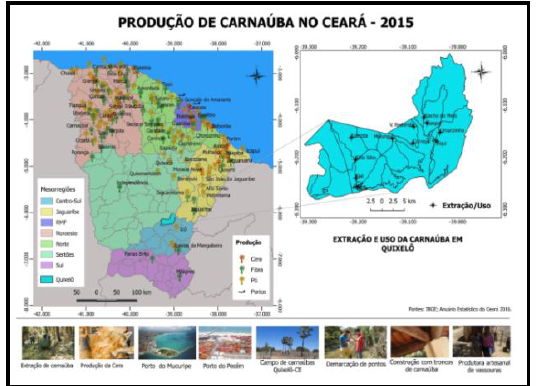
Figure 1. The Carnaúba Palm tree Production in Ceará State, in the northeast of Brazil